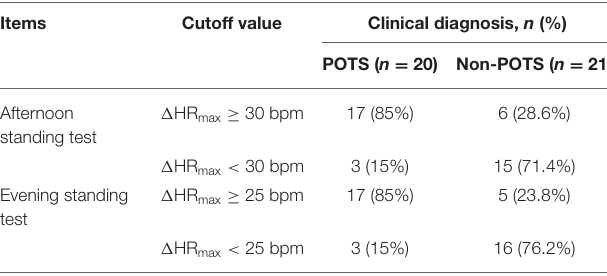
TABLE 4 | The predictive values of the afternoon and evening 1 HR max in the external validation test. Items Cutoff value Clinical diagnosis, n